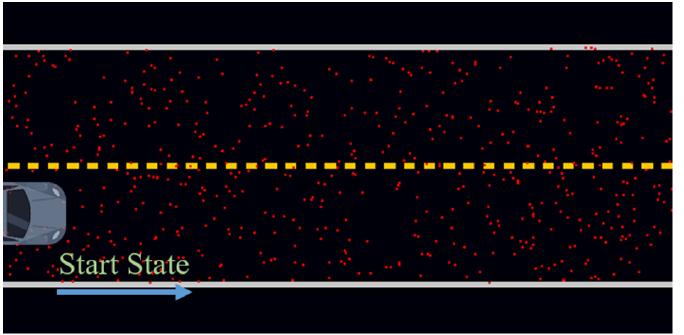
Figure 6. Random distribution sampling.